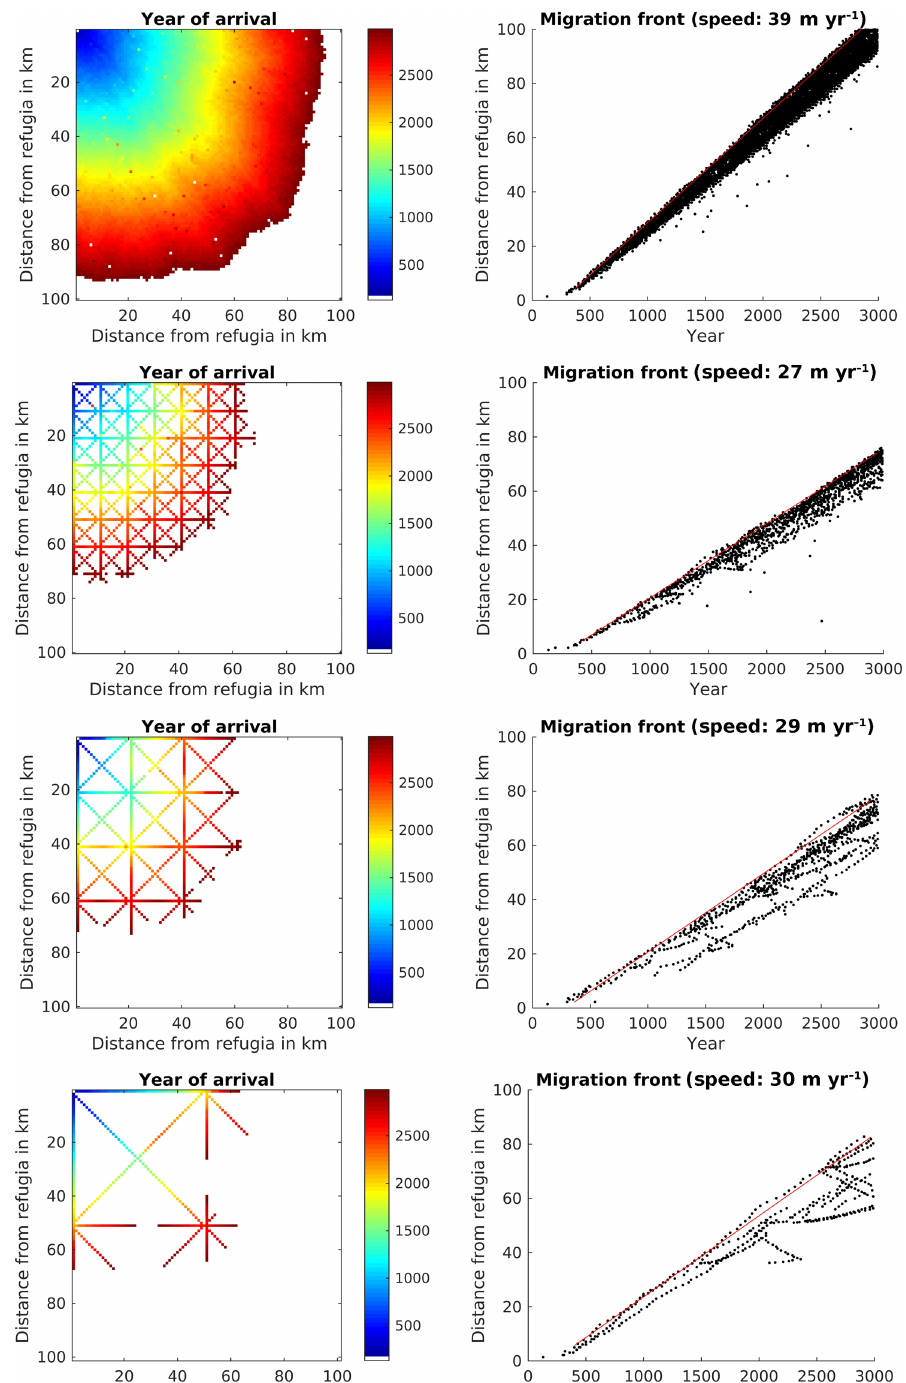
Figure 5. Spread of Fagus sylvatica using the SMSM through an area of 100 × 100 grid cells with identical climate, using the full area (upper row of panels) or corridors every 10th, 20th, or 50th cell. For more explanation see Fig.